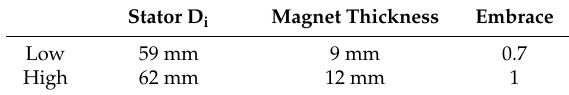
Figure 16. Design variables of the optimal design: ( a ) Stator D i , magnet thickness; ( b ) embrace. Table 5. Boundary condition of the optimal design variables.